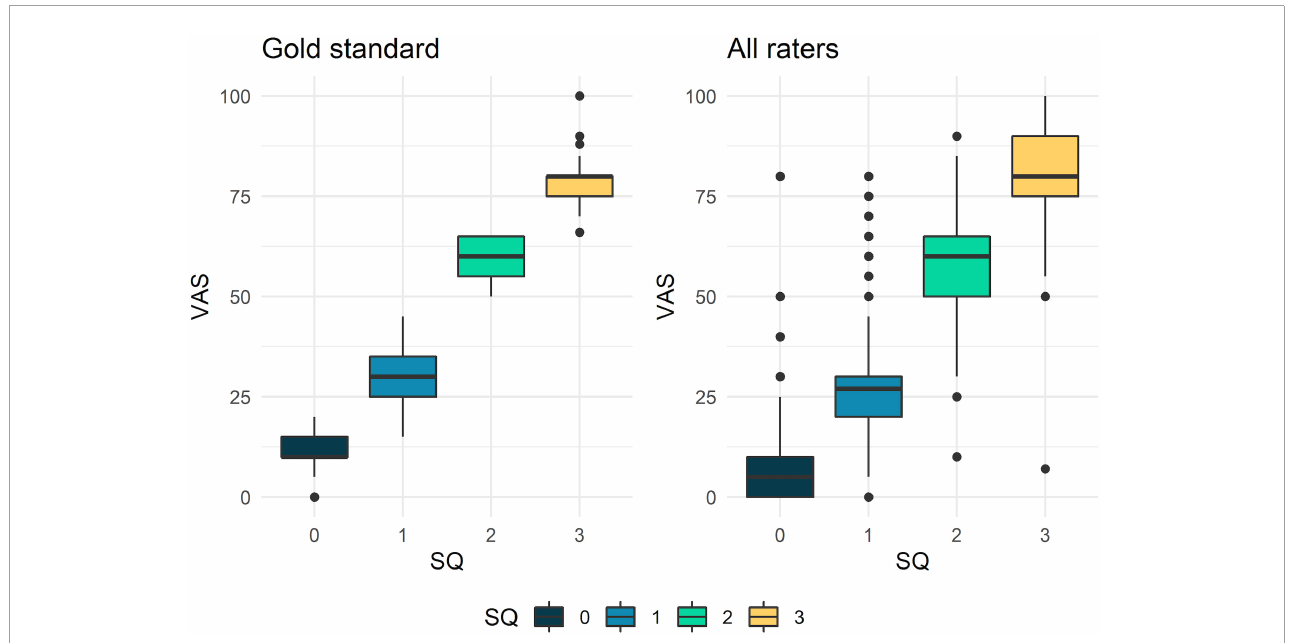
FIGURE2 Boxplot of the joint semi-quantitative and quantitative (VAS echogenicity) ultrasound (US) scales distribution for muscle echogenicity. Box and whiskers plots showing the relationship between the semi-quantitative and the quantitative scores for muscle echogenicity. The upper and lower boundaries of the box represent the third and the first quartiles, respectively. The solid line in the box represents the median. Whiskers represent the maximum and the minimum values.